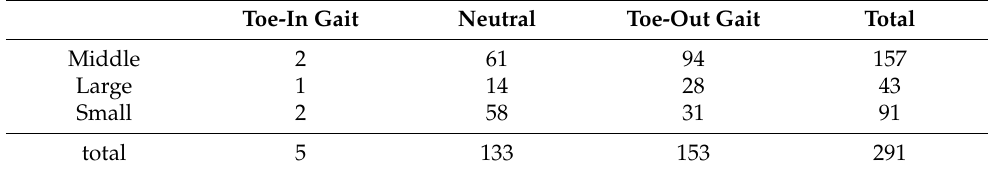
Table 10. Toe-in gait/toe-out gait (X 2 = 18.91, df = 4, p -value = 0.00).